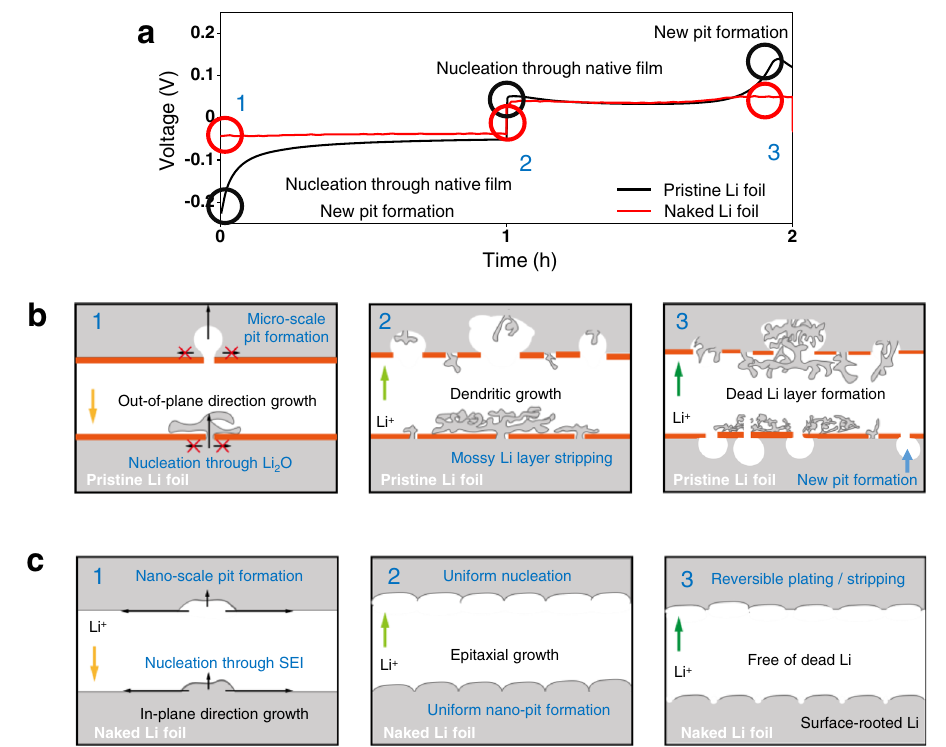
Fig.3|CorrelationbetweenthesurfacestateofLifoilandthepotentialpro fi le in the fi rst cycle. a Galvanostatic charge-discharge voltage pro fi les of the pristine (black) and naked (red) Li-Li symmetric cells in the fi rst cycle. Schematic